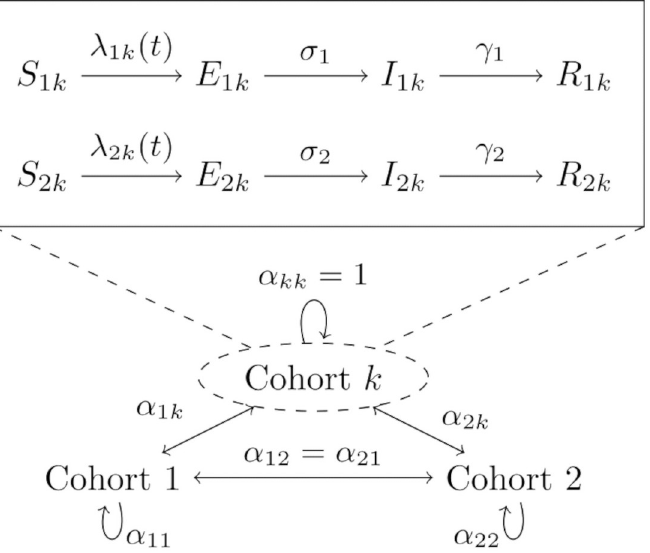
Fig 1. Overview of SEIR compartmental model. The main compartments are denoted by S ( t ), E ( t ), I ( t ), and R ( t ) for susceptible, exposed, infected, and removed, respectively. Compartments are stratified by age class (1—children, 2— adults) and membership to cohort k . The coefficients α 2 [0, 1] account for the strength of interaction between kℓ cohorts k and ℓ